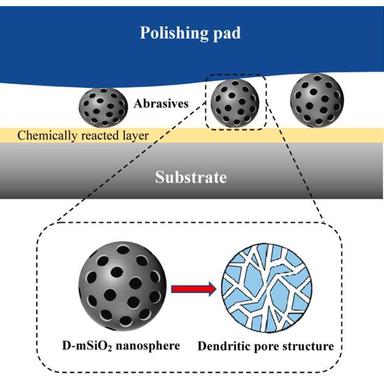
Schematics of (a) the interfacial contact behavior between D-mSiO2 and substrate, and (b) the structural characteristics of D-mSiO2.